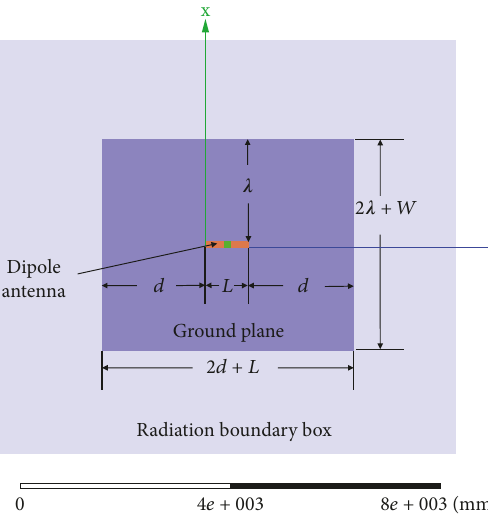
Figure 4: Geometric de fi nitions for the wing span